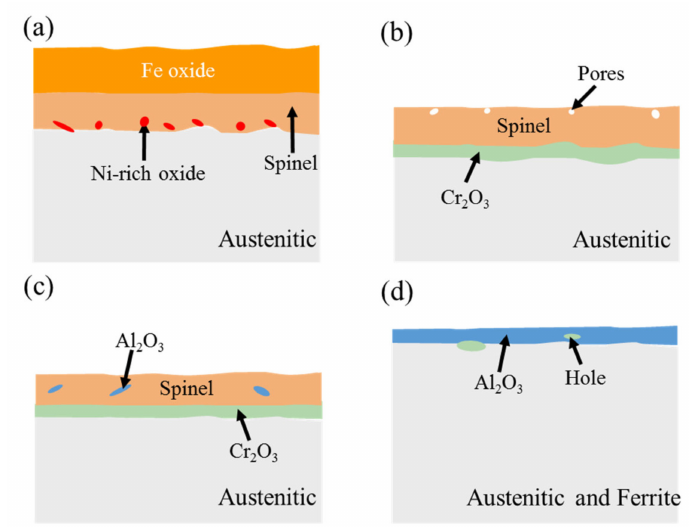
Figure 7. Cross-sectional schematic diagram of ZG40Cr20Ni20Al x steels with ( a ) 0, ( b ) 1.76, ( c ) 3.45, and ( d ) 5.34 wt%